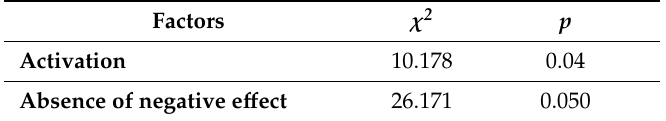
Table 4. Results for the Kruskal–Wallis H test for the dimensions analyzed.